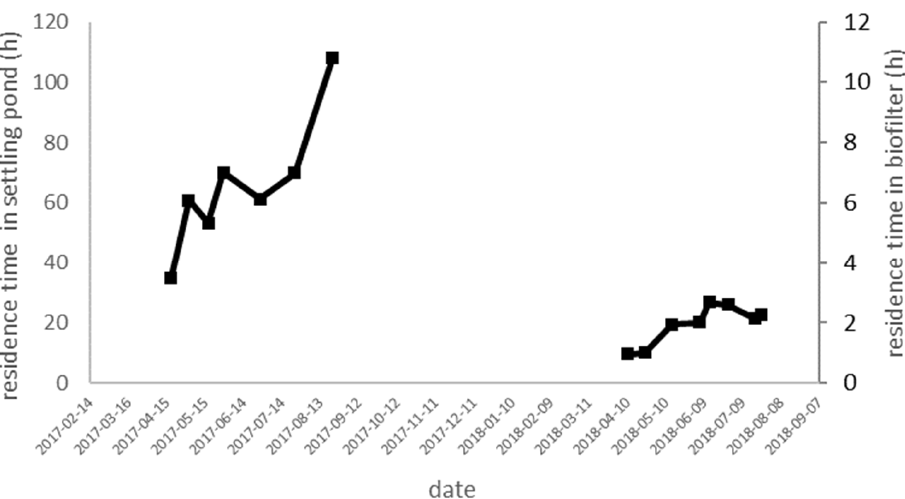
Figure 2. Evolution of hydraulic residence time (HRT) in the settling pond and in the biofilter in 2017 and in 2018. The values for the settling pond and the biofilter are directly proportional (factor of 10) because they both depend on the same flow-rate and on fixed volumes. The left Y -axis gives the scale for the settling pond and the right Y -axis gives the scale for the biofilter.